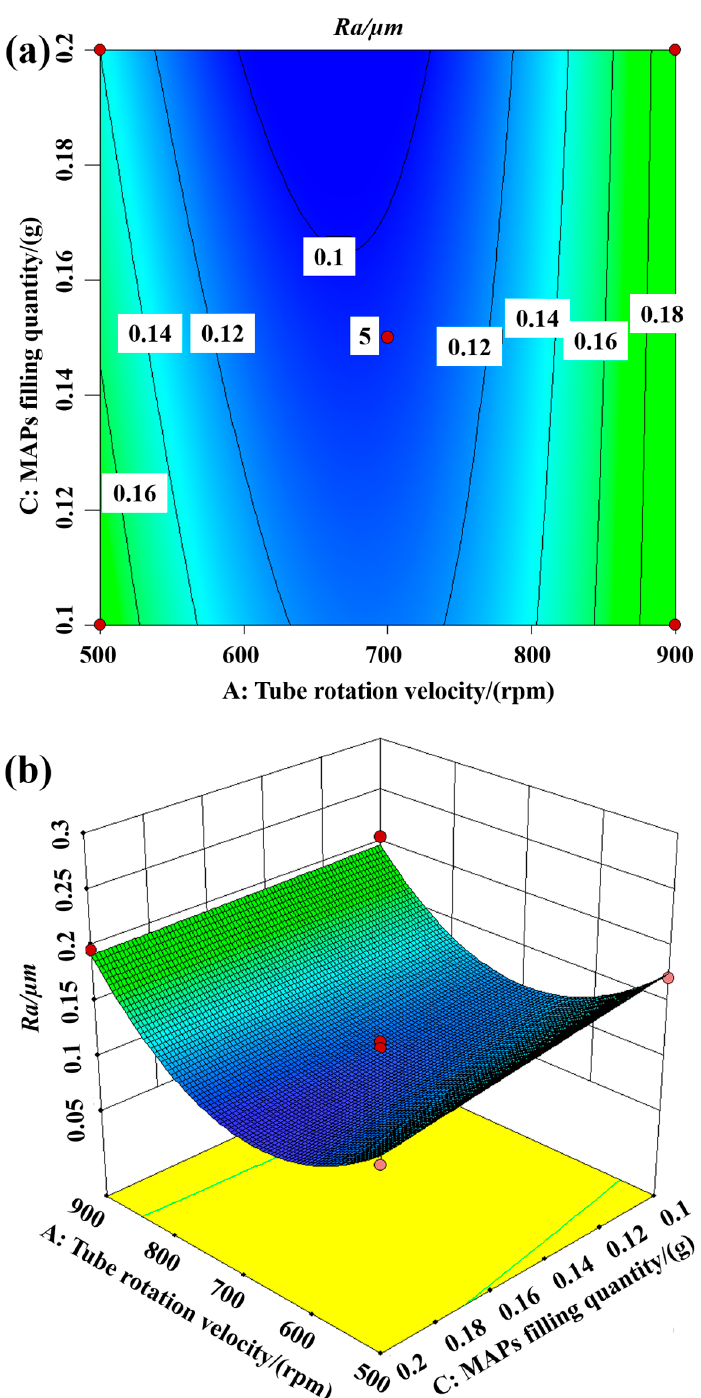
Figure 9. Interaction of tube rotation velocity and MAPs filling quantity on surface roughness: ( a ) contour; ( b ) 3D response surface.